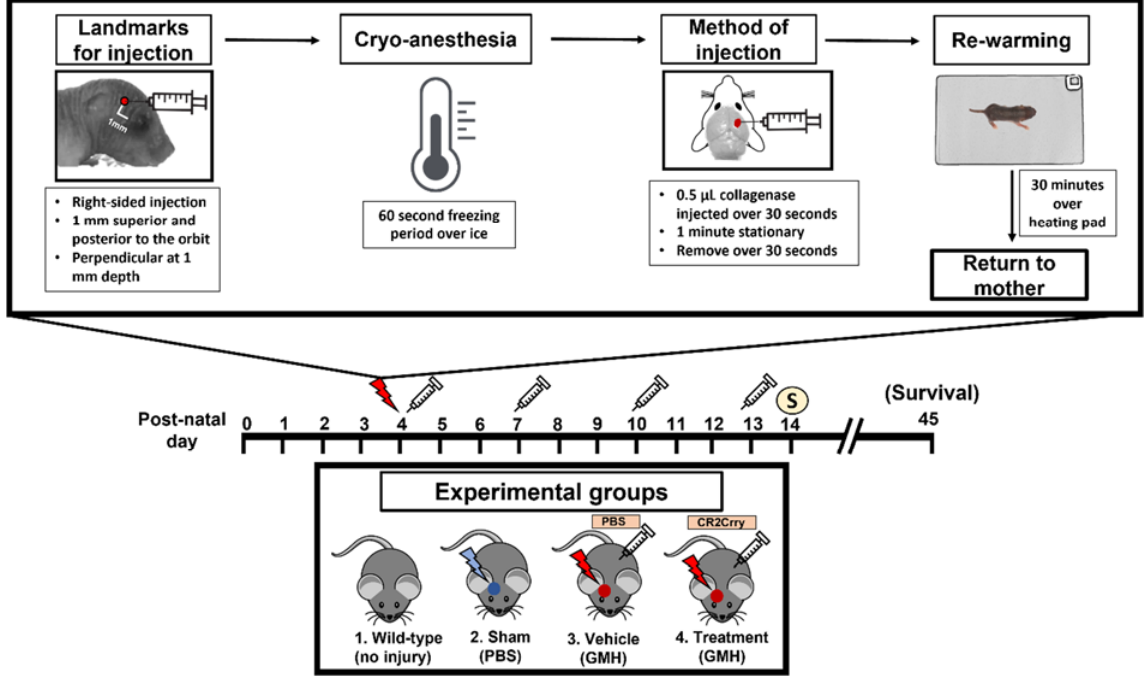
Figure 1. Workflow of surgical procedure and treatment paradigms for all experimental groups. At P4, the surgical coordinate was marked, and pups were cryo-anesthetized. Then, 0.5 µL of collagenase was injected into the subventricular zone of the brain via a lateral transcortical approach, and pups were returned to their mother after re-warming. The experimental groups were (1) Wild-type non-injured (Naïve), (2) PBS injected into the SVZ (Sham), (3) Collagenase injected into the SVZ and subsequent IP treatment with PBS (Vehicle control), and (4) Collagenase injected into the SVZ and subsequent IP treatment with CR2Crry. Mice received first PBS or CR2Crry treatment 1 h after collagenase injection and at subsequent 3-day intervals as indicated (depicted by syringe). Mice were euthanized for sample collection on post-natal day 14 or monitored for survival (up to day 45).